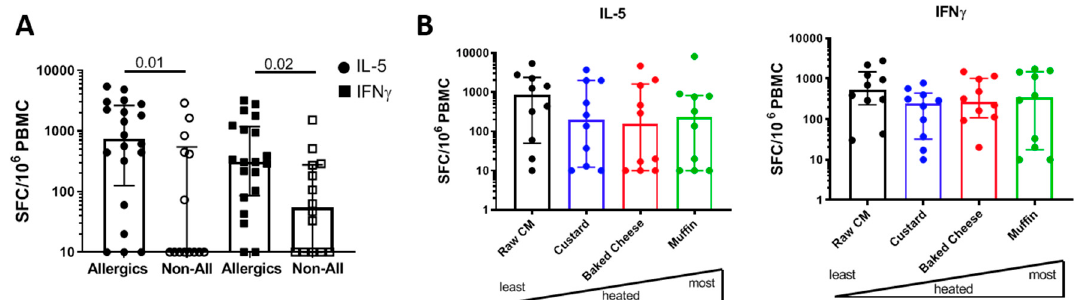
Figure 4. T cell cytokine production in response to raw, pasteurized CM and heated CM-containing food extracts. ( A ) A bar graph showing IL-5 and IFN γ production in response to re-stimulation with raw, pasteurized CM extract after a two-week expansion culture (allergic subjects n = 20, non-allergic subjects n = 14). ( B ) Bar graphs showing IL-5 (left panel) and IFN γ (right panel) production in response to re-stimulation with raw, pasteurized CM (black), custard (blue), baked cheese (red) and muffin (green) extracts after two-week expansion culture (n = 10). Bars represent medians, with error bars showing interquartile means. Statistical analysis was performed by Mann-Whitney test (two-tailed), p < 0.05 considered significant.